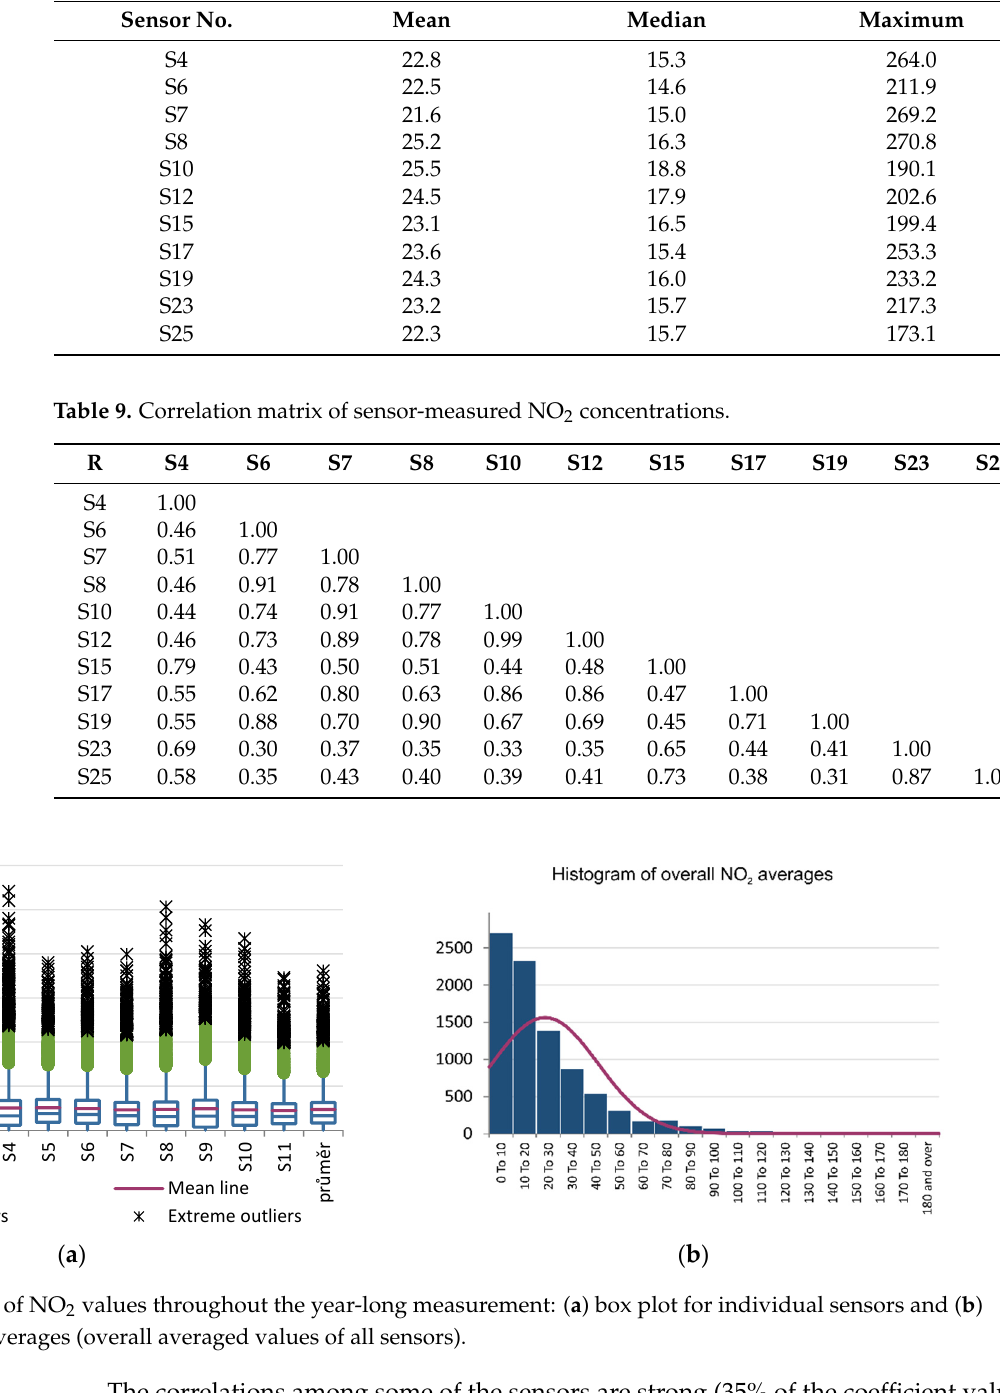
Table 10. Data used to determine the validation factor (NO 2 , sensor unit no. S25).